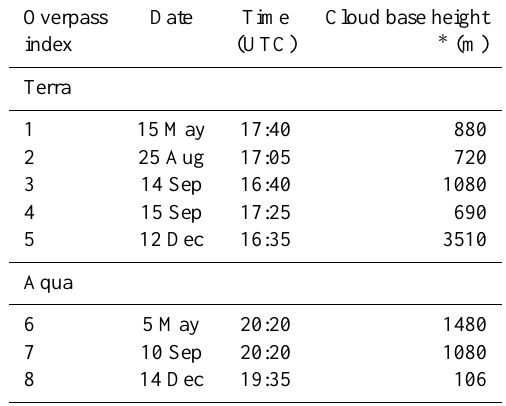
Table 6. Information on Terra/Aqua MODIS overpasses at the ARM Oklahoma site in 2007 used for evaluations of cloud-mode